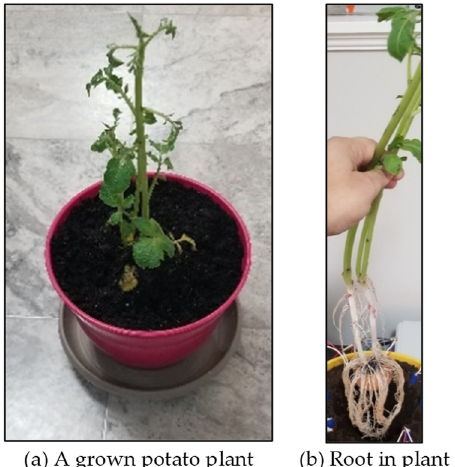
Figure 18. (a) A grown potato plant, and ( b ) a potato root system in plant. Figure 18. ( a ) A grown potato plant, and ( b ) a potato root system in